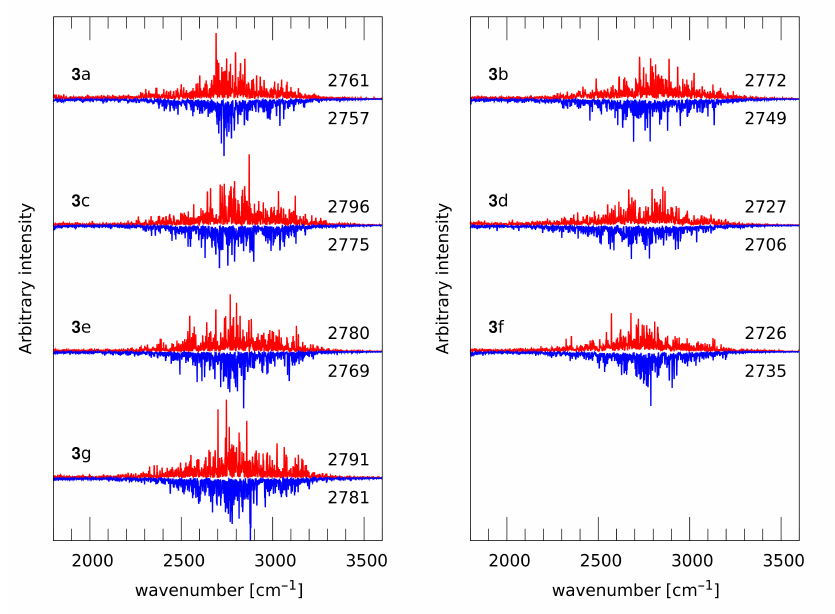
Figure 9. The bridge proton O-H stretching regions of the atomic velocity power spectra—CPMD simulation results for the compounds of group 3 . Red lines—H 1 protons, blue lines—H 2 protons. Barycenters (in cm − 1 ) of each signature are given to the right of each